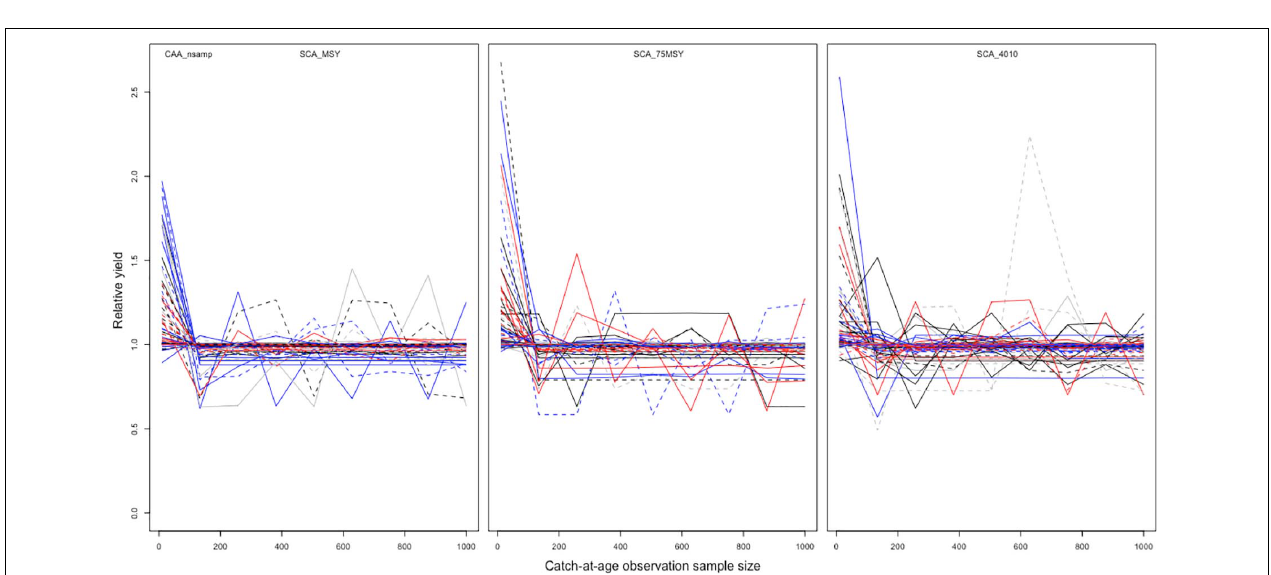
FIGURE 4 | Results of 128 simulations of the parameters Mbias and Kbias with three MPs.